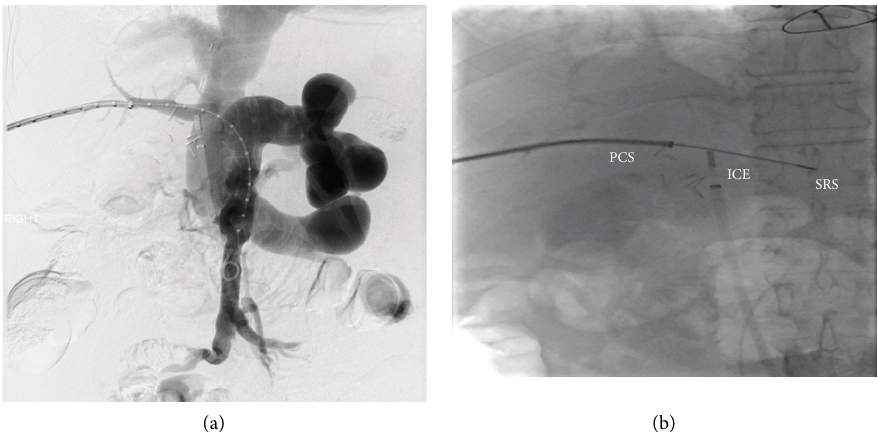
Figure 3: a & b: portal vein access. Challenging and relatively central access is due to diminutive portal vein branches. Intravascular ultrasound guidance.